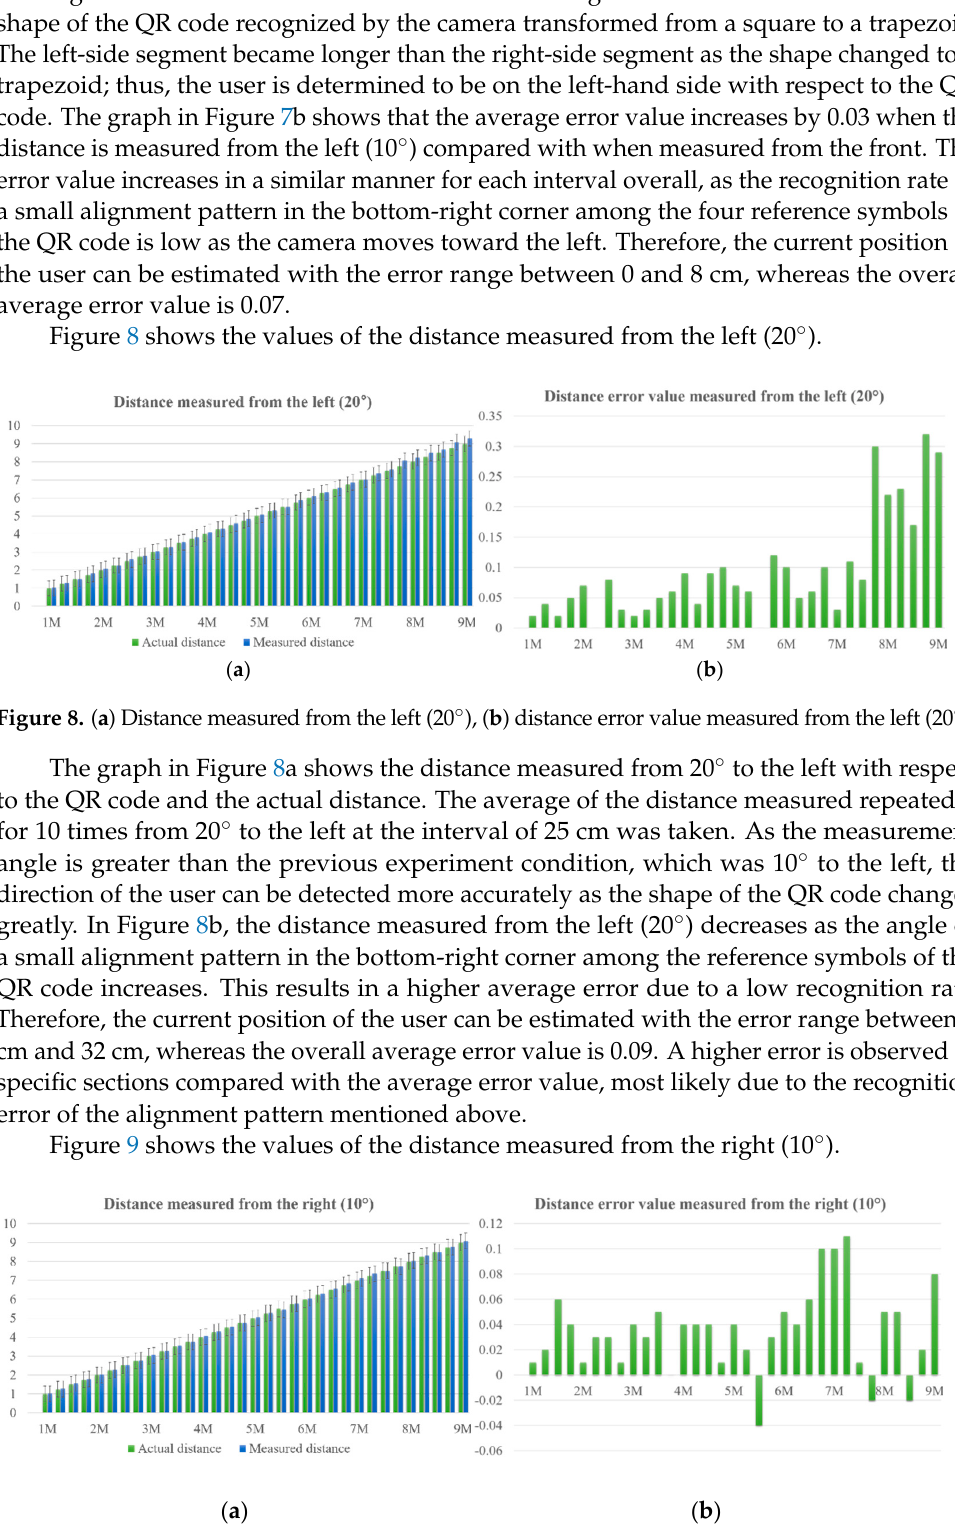
( b ) Figure 10. ( a ) Distance measured from the right (20°), ( b ) distance error value measured from the right (20°). The graph in Figure 10a shows the distance measured from 20° to the right with re- spect to the QR code and the actual distance. The average of the distance measured 10 times repeatedly from 20° to the right at the interval of 25 cm was taken. Unlike the left side, a recognition error of a small alignment pattern did not occur when the camera was moved 20° to the right, thus exhibiting a similar level of accuracy as when the camera was